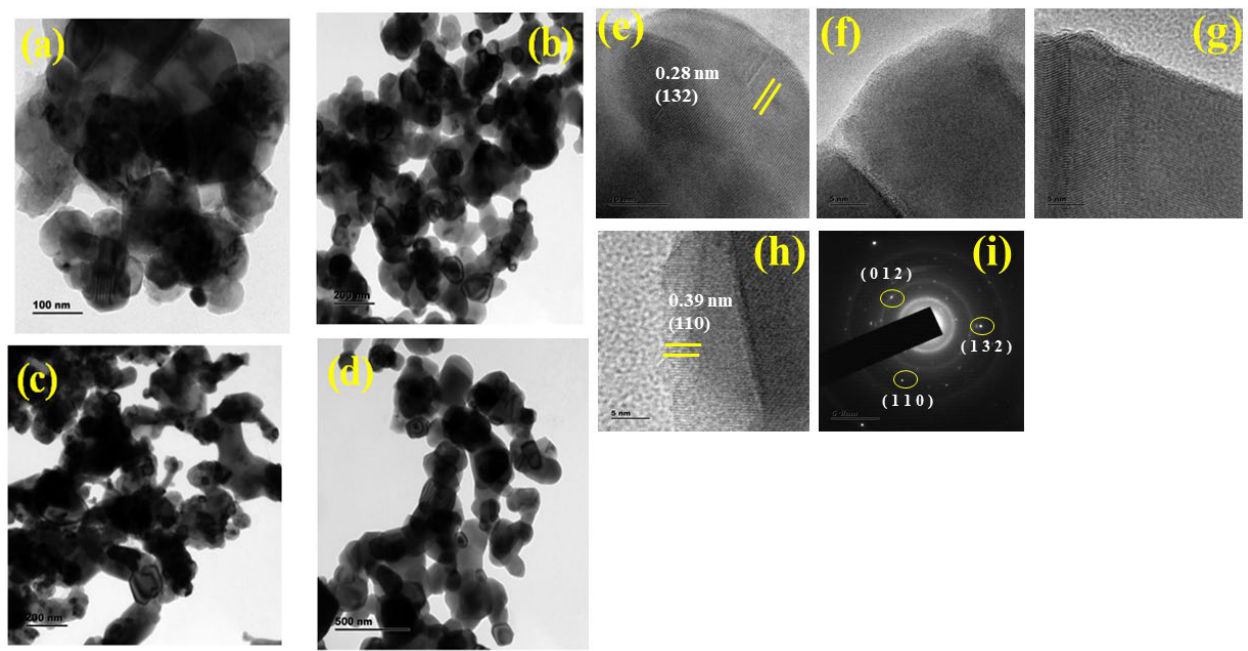
Figure 4. ( a – d ) HRTEM images of NMFF1, NMFF2, NMFF3, and NMFF4, ( e – i ) HRTEM fringes image of NMFF1-NMFF4.